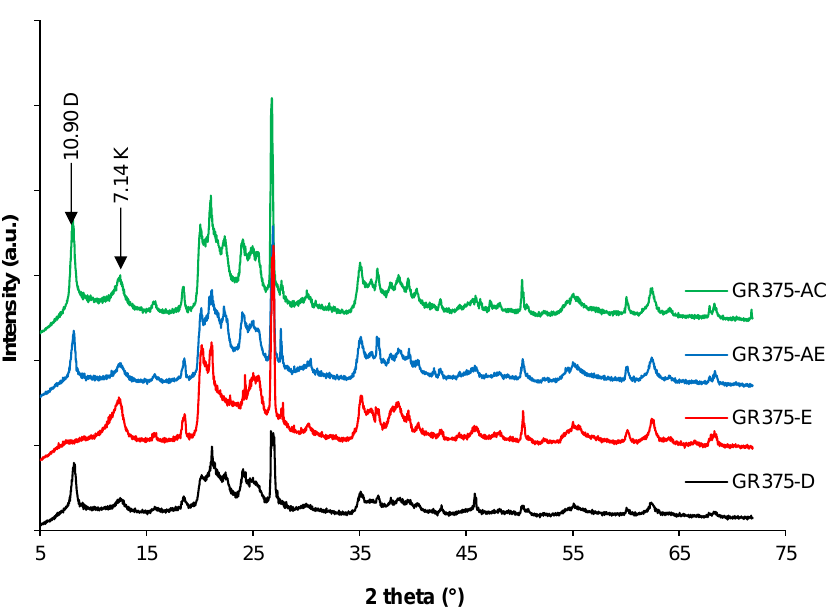
Figure 4. XRD patterns of the DMSO–Kaolinite (GR875-D) and the products of deintercalation in water (GR375E), in ethyl acetate (GR375-AE), and in acetone (GR375-AC). Note: D = kaolinite–DMSO complex; K: kaolinite.